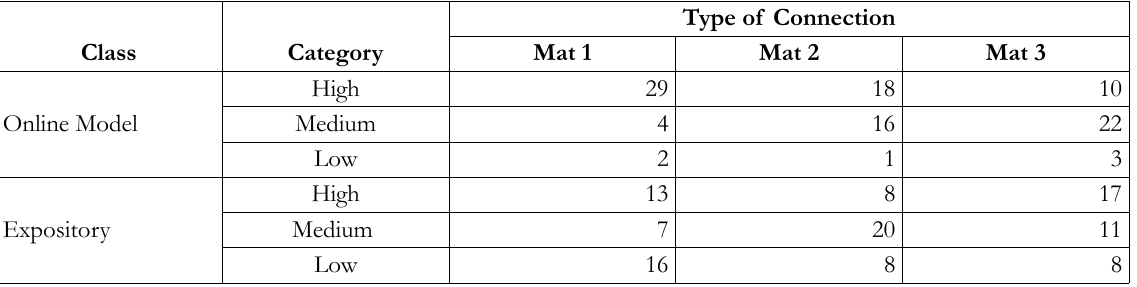
Table 6. Mathematic Connection Skill According to the Type of Mathematic connection